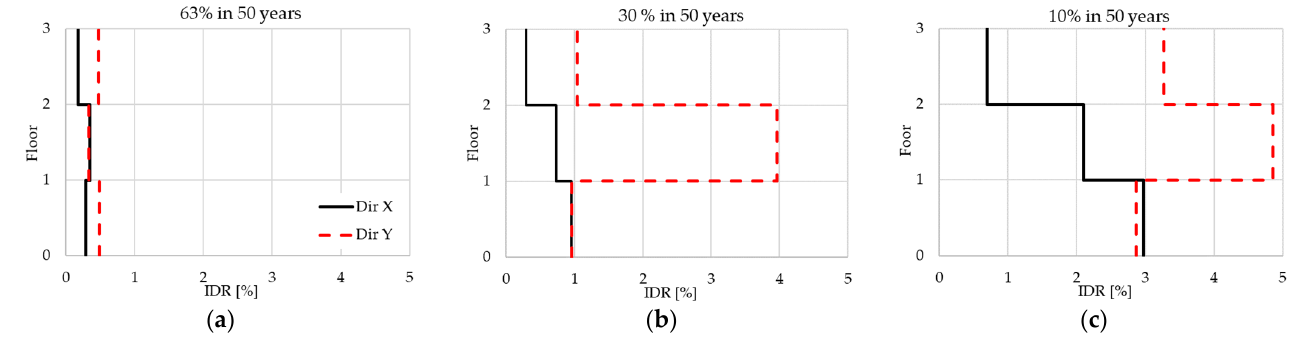
Figure 5. Median values of IDR for the time-history analyses at ( a ) 63%, ( b ) 30% and ( c ) 10% in 50 years of HLs (solid line X direction, dashed line Y direction).